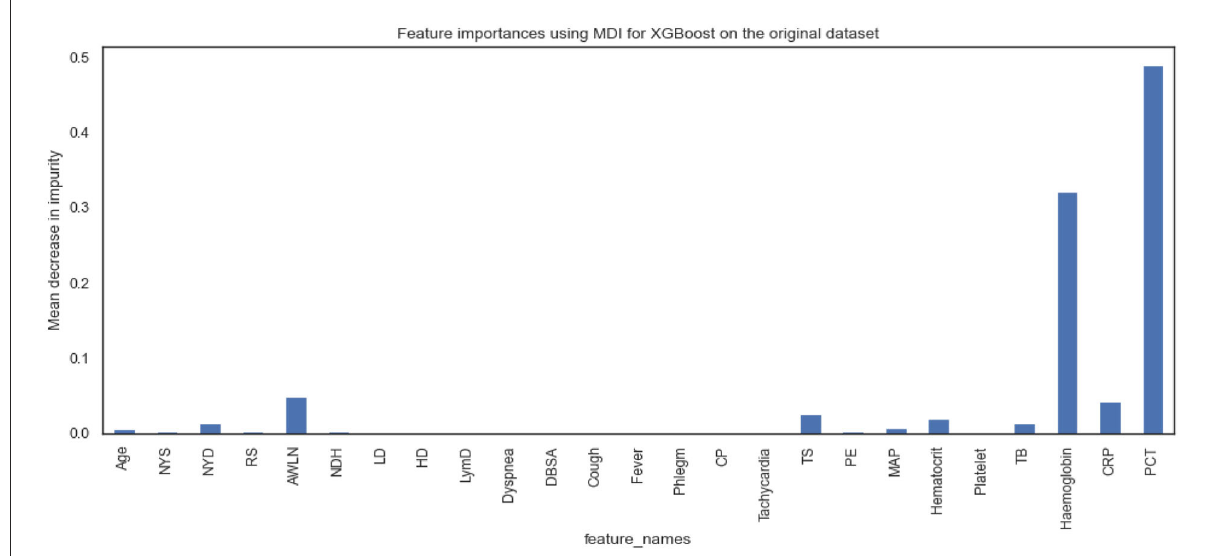
FIGURE5 Feature importance according to XGBoost model on the original dataset.